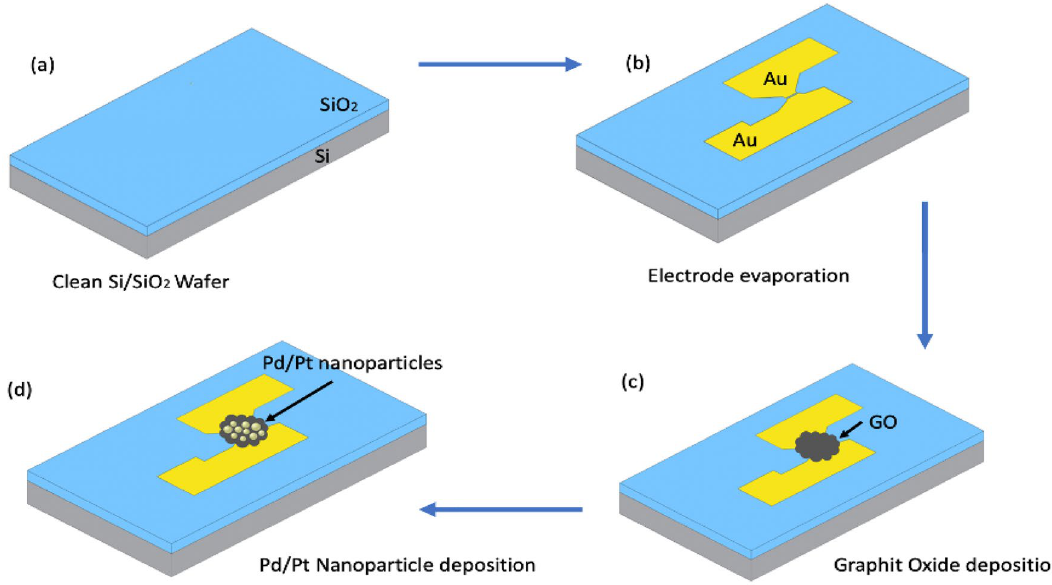
Figure 1. Schematic representation of the fabrication steps of the GO-FET biosensor. ( a ) The Si/SiO 2 wafer was cleaned with acetone, ethanol, and deionized water. ( b ) Thermal evaporation was used to deposit the gold source and drain. ( c ) A graphite oxide drop was placed to form the channel. ( d ) Pd/Pt composite nanoparticles were sputtered on the graphite oxide channel using an Ultra High Vacuum compatible system